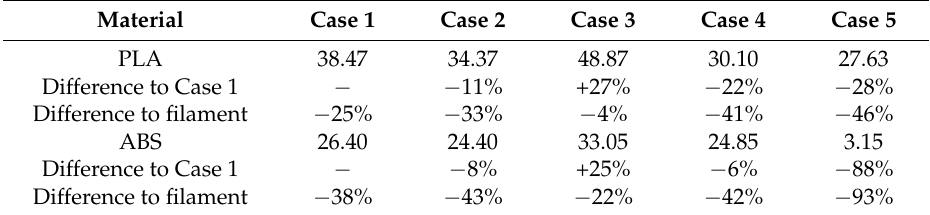
Table 10. The comparison of mechanical strength with the benchmark case and the filament. Material Case 1 Case 2 Case